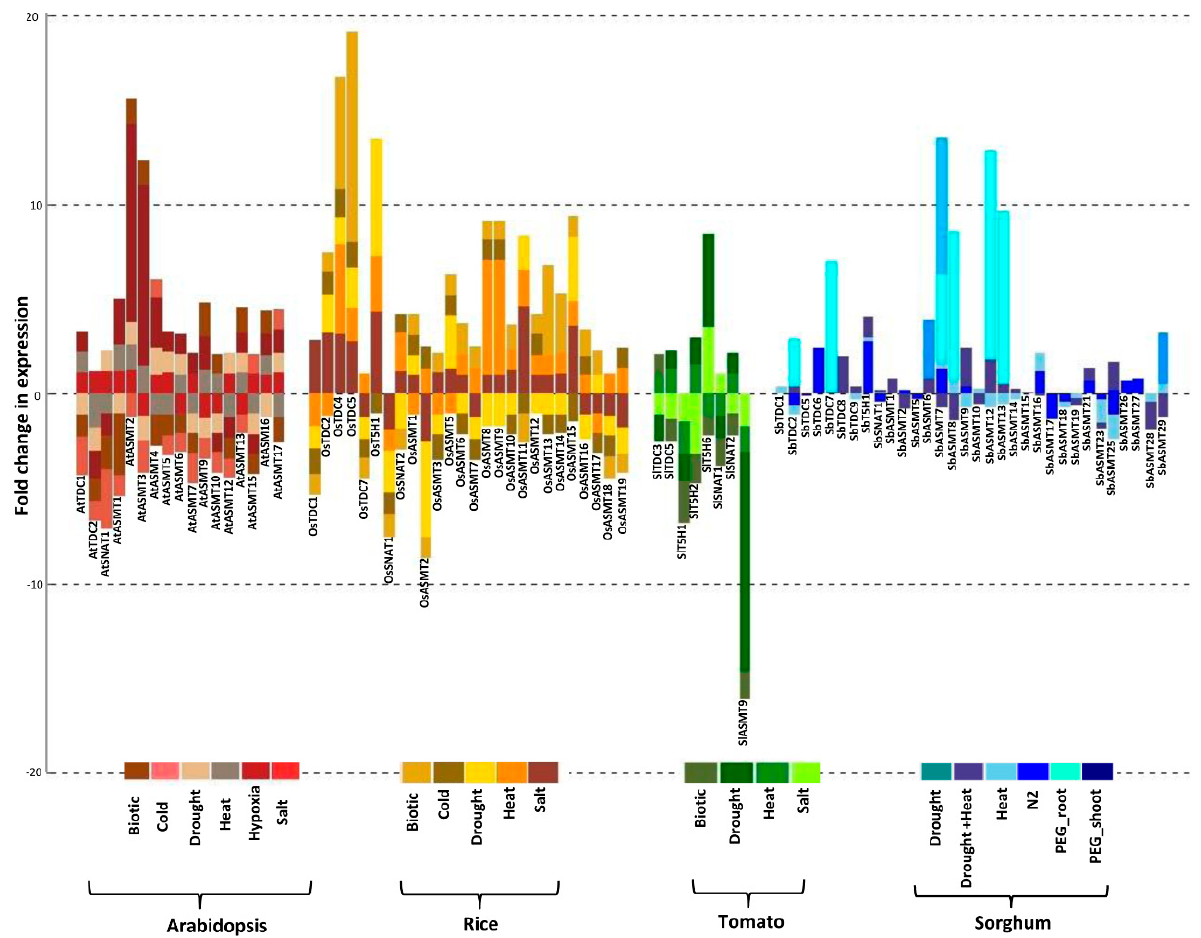
Figure 6. Stress-mediated regulation of genes encoding Ser and Mel biosynthetic enzymes in different plant species. Stacked bar plots depicting expression profiles of genes encoding Ser and Mel biosynthetic enzymes in rice, Arabidopsis and tomato were obtained from the publicly available Genevestigator database. Perturbation data for the Sorghum genes was obtained from the Expression Atlas database. Stacked bar plots were generated using R package. Levels of expression have been indicated by the Y axis. The colour bars at the bottom of the graph represent the different stress conditions.